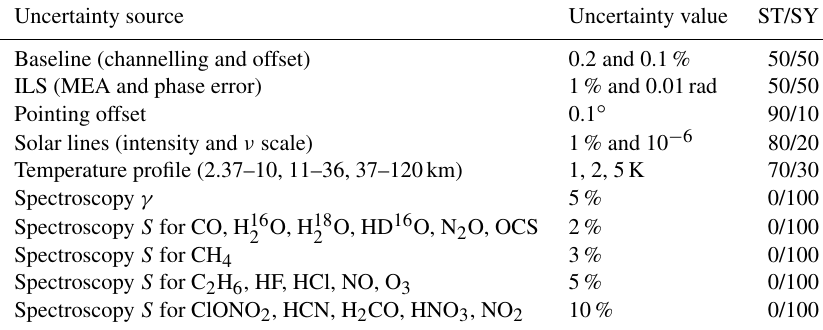
Table A1. List of sources and values used for the uncertainty analysis. (MEA: modulation efficiency amplitude; ν scale: spectral position; S : intensity; γ : pressure broadening parameter). The third column provides the partitioning of the error values between statistical (ST) and systematic (SY)